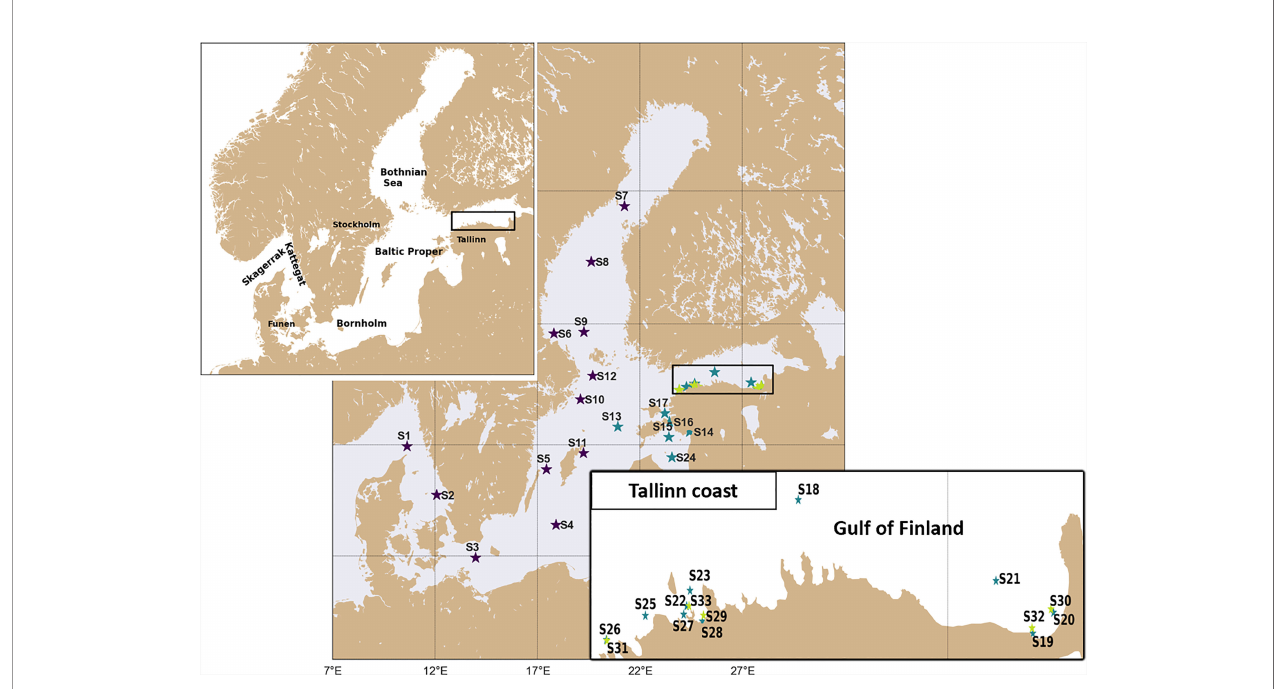
FIGURE 1 | Station locations and IDs from three microplastic datasets: CLAIM dataset - green; Data from Schönlau et al. (2020) - black and TalTech dataset - blue. Locations and station names are given in Table S1 in Supplementary Material